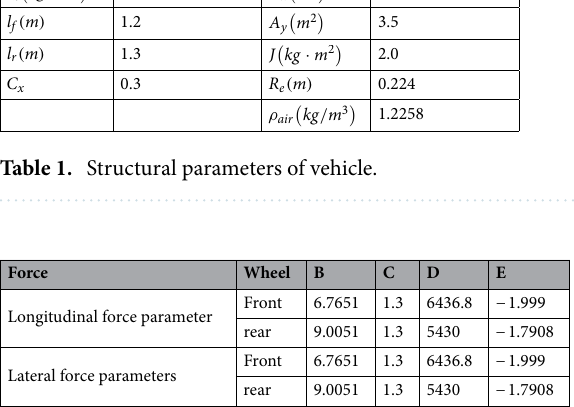
Table 2. Tire force parameters under high adhesion